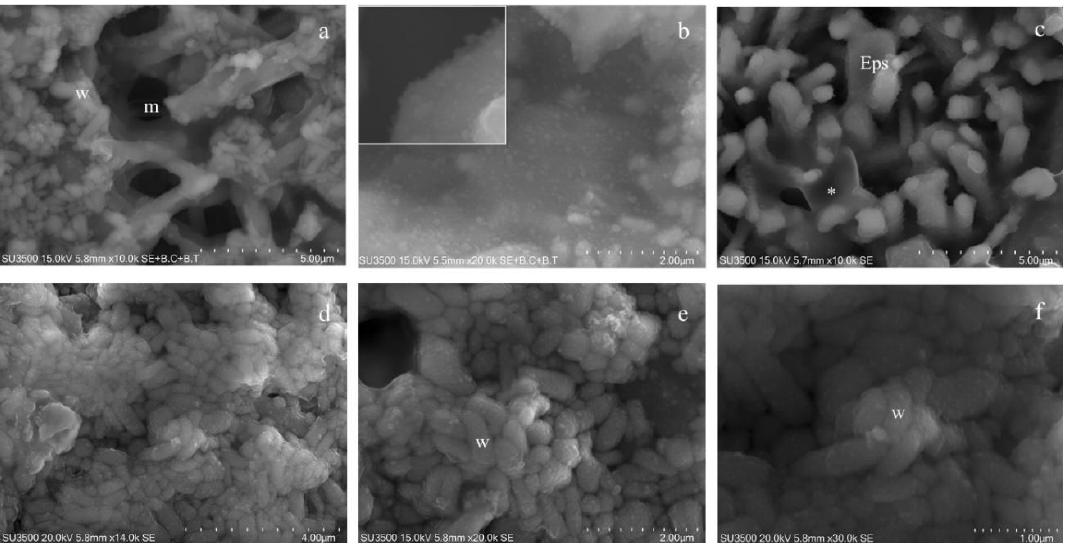
Figure 5. Characterization of S. wiggsiae bacterial cells. ( a ) At a very high magnification, 10000×, the biofilm trabecular areas appear populated by clusters of bacteria, w, S. wiggsiae , m, microcanalicular system. ( b ) Fine granular aggregates with a cloudy appearance are scattered onto the matrix surface 10000X (inset 35000×). ( c ) Thin matrix sheets, asterisk, connect digitiform extroversions in granular areas creating walls of a canalicular system, 10000×. ( d ) At a very high magnification, bacteria appear as compact clusters of elongated cells without pili or flagella, 14000×. ( e ) A thin veil of hydrated matrix covers bacteria, w, giving them a cloudy appearance, 20000×. ( f ) Very high magnification, 30000×, allows the identification of S. wiggsiae bacterial cells, w, as elongated bacteria without surface extroversions.